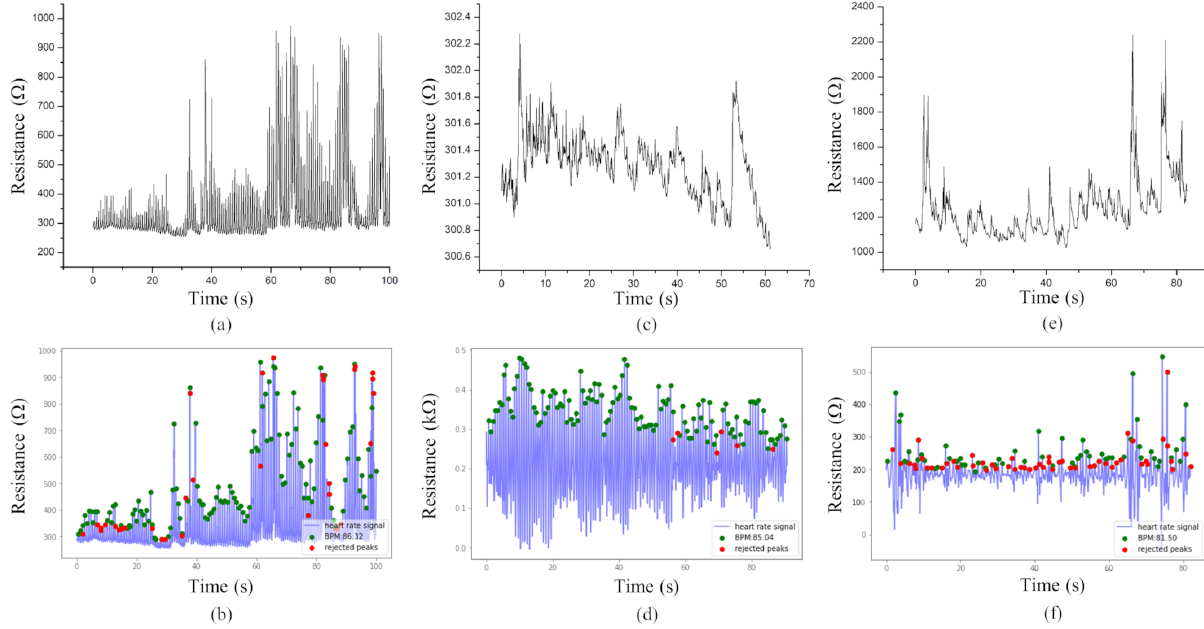
Figure 4. Measurements and analysis of heartbeat. ( a ) Resistance variation in time, as vein pulsing is measured with LIG on polyimide. ( b ) The same data as in ( a ), after processing with HeartPy. Green points mark peaks that were selected for heart rate analysis, while red points mark peaks that the algorithm found to be erroneous. ( c ) Resistance variation in time, as vein pulsing is measured with LIG on polyimide, protected with a PDMS layer on top. ( d ) The same data as in ( c ), after processing with HeartPy. ( e ) Resistance variation in time, as vein pulsing is measured with graphene completely transferred to PDMS. ( f ) The same data as in ( e ), after processing with